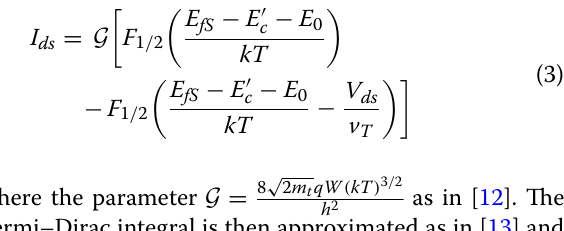
where the parameter E f is the Fermi energy level. The ( E ′ E j KE ) , is represented in energy level E c + = + 0. For non- Fig. 2. Under equilibrium conditions I ds = equilibrium conditions, the net drain to source current is expressed using one sub band approximation (lowest being j 0 of unprimed valley) as =